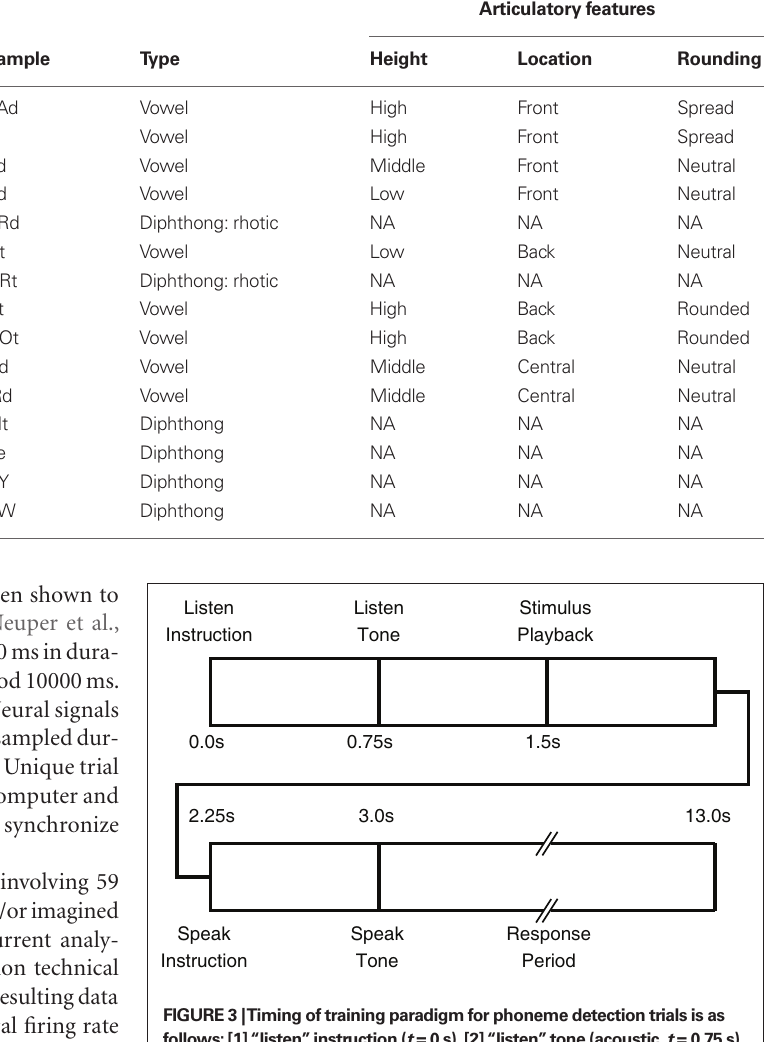
Table 1 | Vowel and diphthong stimuli used for the phoneme production experiment.